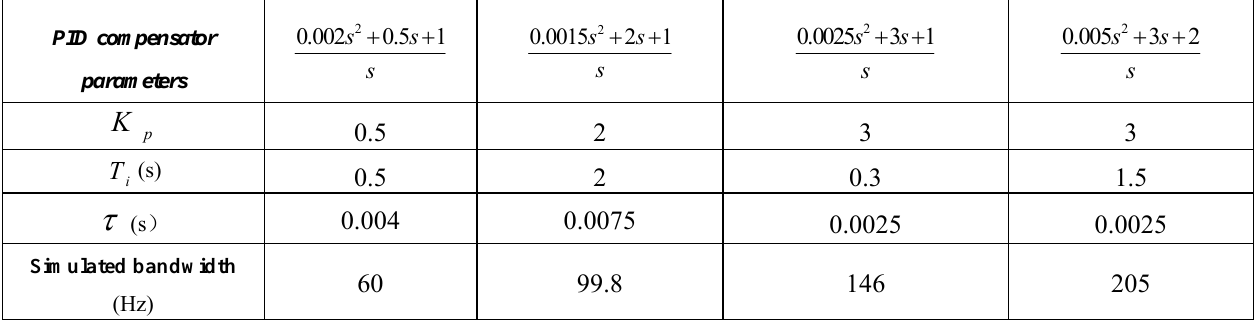
Table 1. Effect of the PID compensator’s parameters on the system